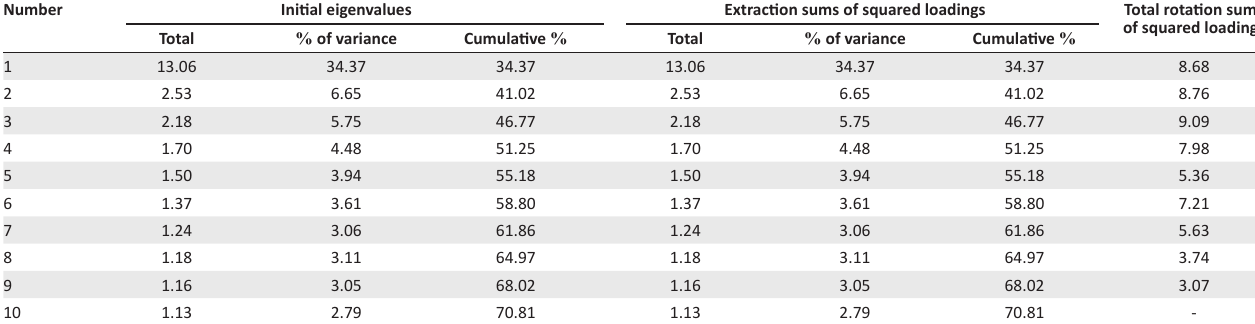
TABLE 1: Eigenvalues larger than one and explanation of variance. Number Initial